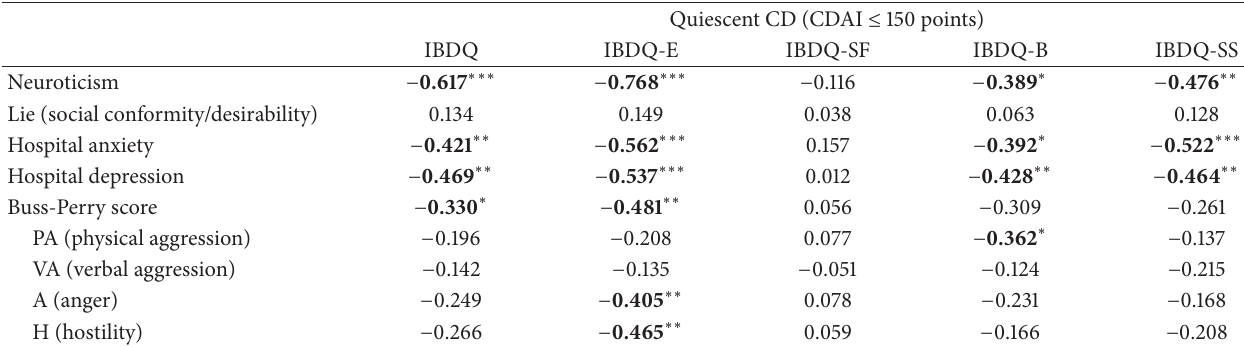
Table 4: Spearman correlation analysis ( P value) between different psychological variables and Inflammatory Bowel Disease Questionnaire and its subscales in patients with quiescent Crohn’s disease (CDAI ≤ 150 points).